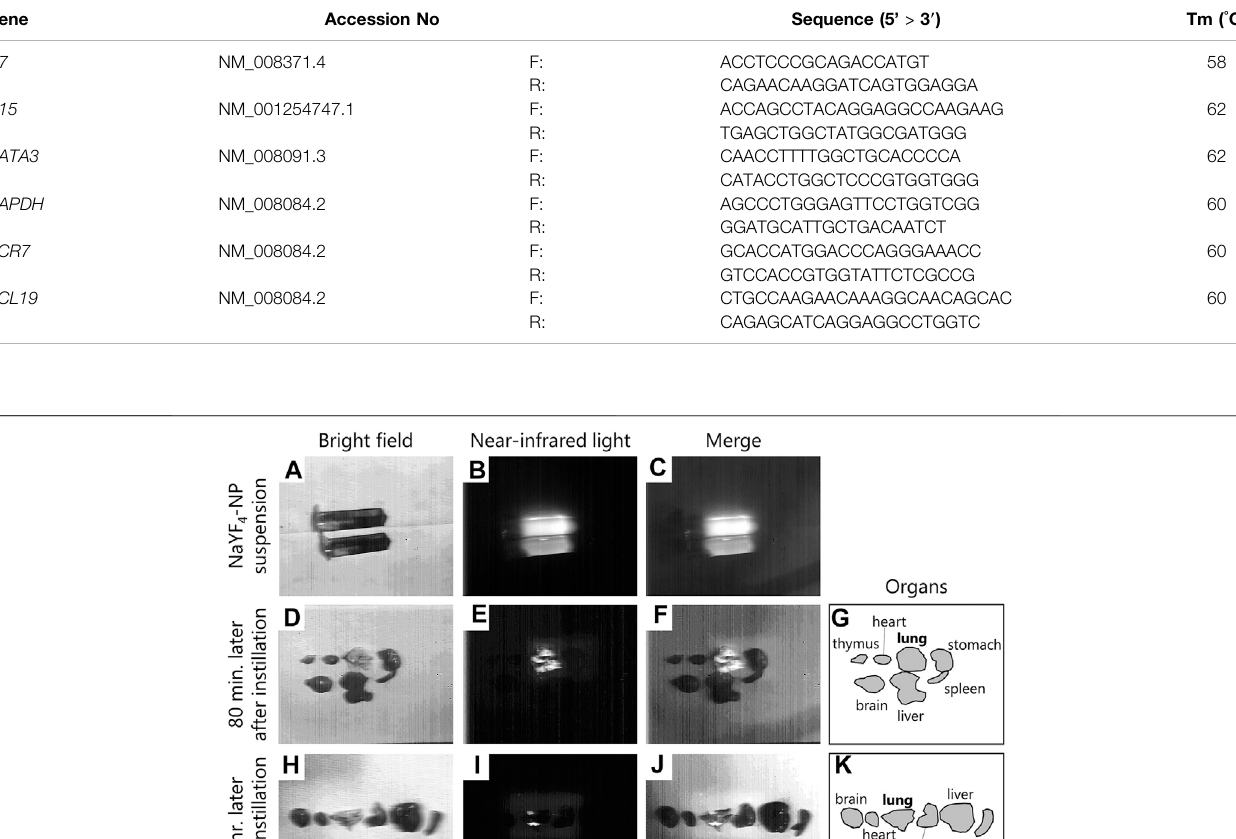
Frontiers in Toxicology |